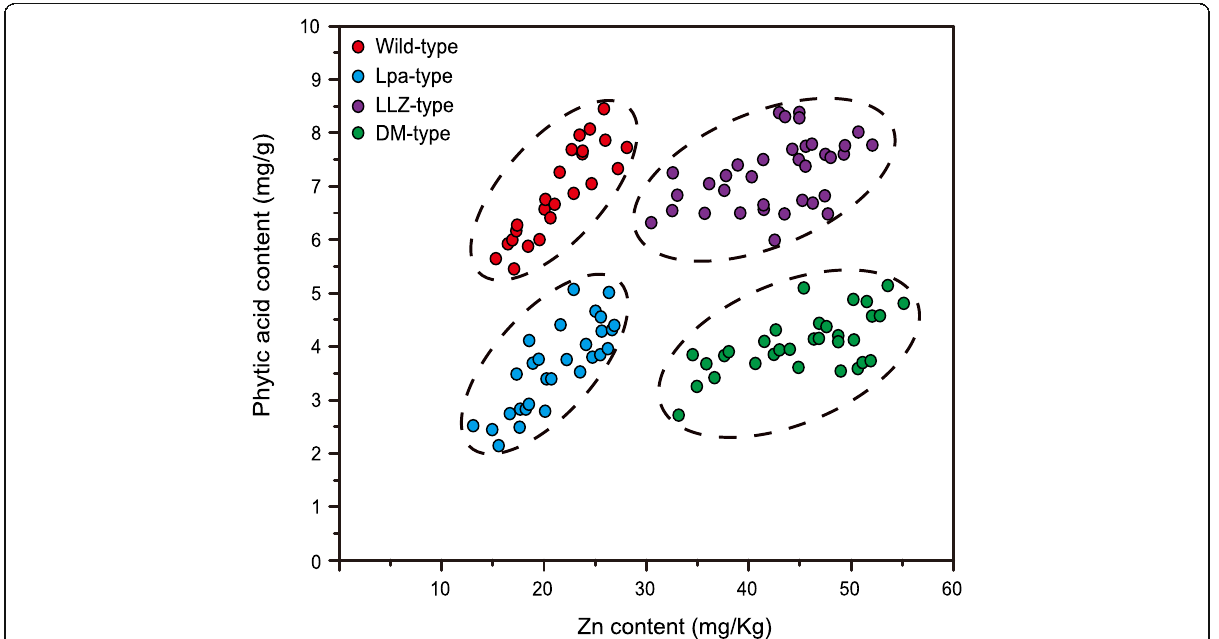
Fig. 2 Distribution of Zn and phytic acid content in brown rice for the cross-bred